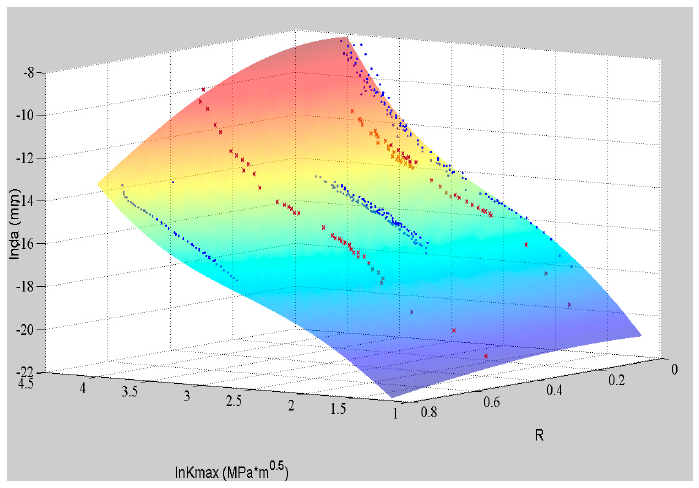
Figure 4. The experimental data of Al7075-T6 and the corresponding ANN.